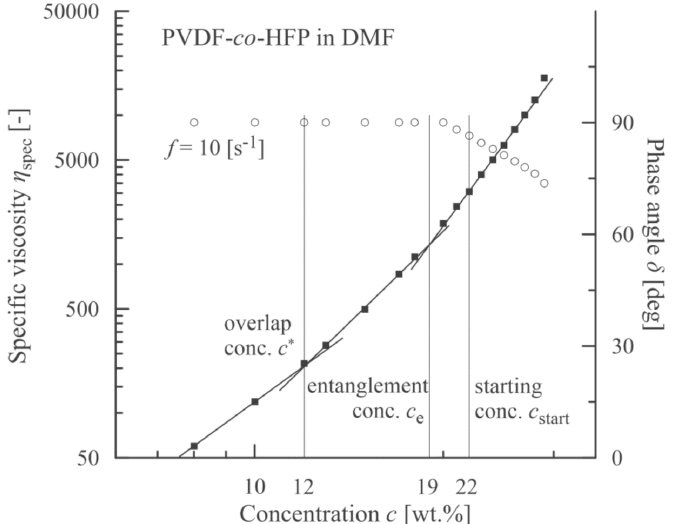
Figure 2. Correlation between an onset of viscoelasticity (a decrease in phase angle, open circles) and a starting concentration corresponding to an onset of beadless PVDF- co -HFP nanofibers. Based on elastic (storage) G ’ and viscous (loss) G ” moduli, a course of the phase angle δ (tan δ = G ”/ G ’) is depicted in Figure 2. A value of concentration for which the phase angle starts to decrease (slightly more than 20 wt.%) corresponds to the formation of network structures among the polymer chains and exceeds a location of the entanglement concentration ( ≈ 19